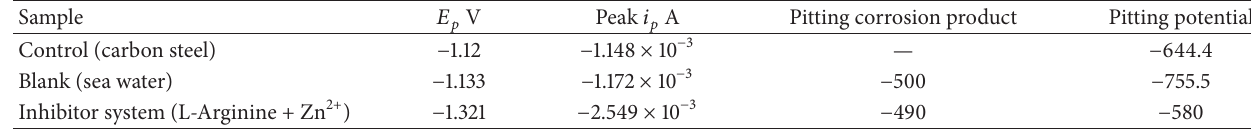
Table 8: Cyclic voltammetry parameters (L-Arginine + Zn 2+ ). Pitting corrosion product Pitting